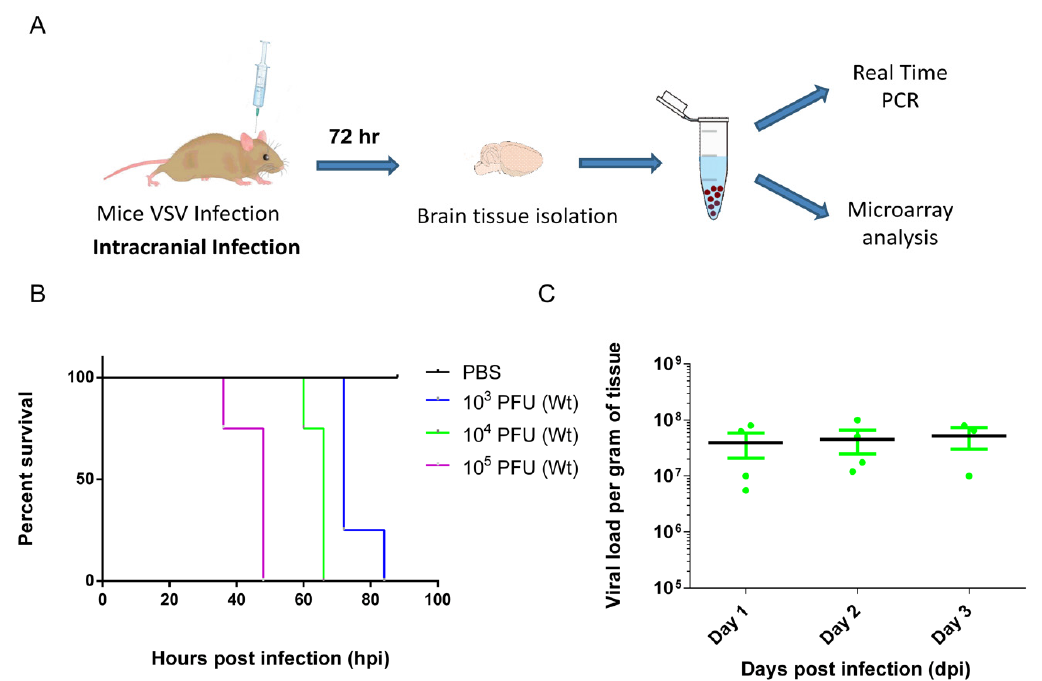
Figure 1. Vesicular stomatitis virus (VSV) infection in the central nervous system (CNS) induces fatal encephalitis in wild type mice. ( A ) B6 mice ( n = 4 per group) were injected intracerebrally with the designated doses of VSV to induce encephalitis. Intracardially perfused mouse brain was collected after 72 hpi to estimate brain viral load and to collect total cellular RNA. Total cellular RNA was later used for gene microarray analysis as well as for validation of real-time PCR assays. ( B ) Kaplan–Meier survival curve of animals challenged with the varying doses of VSV (doses represented in plaque-forming units (PFU) of VSV are shown in the panel to the right of the graph). ( C ) In this experiment, all animals were intracerebrally injected with 10 4 PFU of VSV, and brain viral loads were determined by plaque assay technique conducted in Vero cells at said time points and reported as PFU of VSV per gram of tissue.